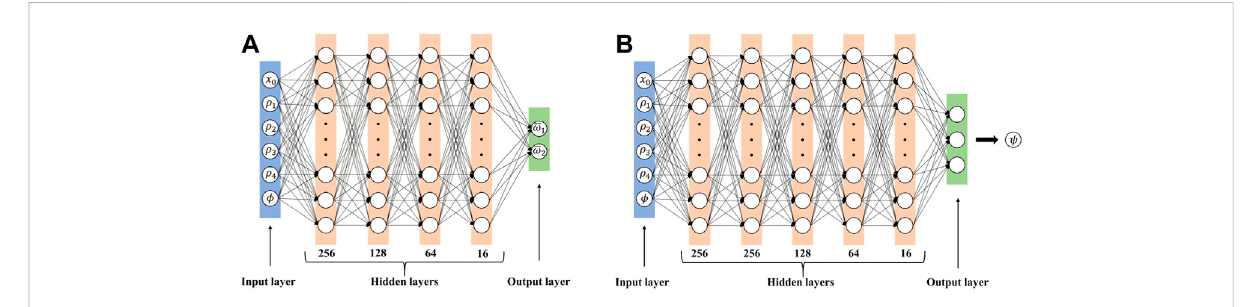
FIGURE 4 (A) The regression neural network for predicting the normalized bounds of the objective bandgap, and (B) the classi fi cation neural network for predicting the vortex